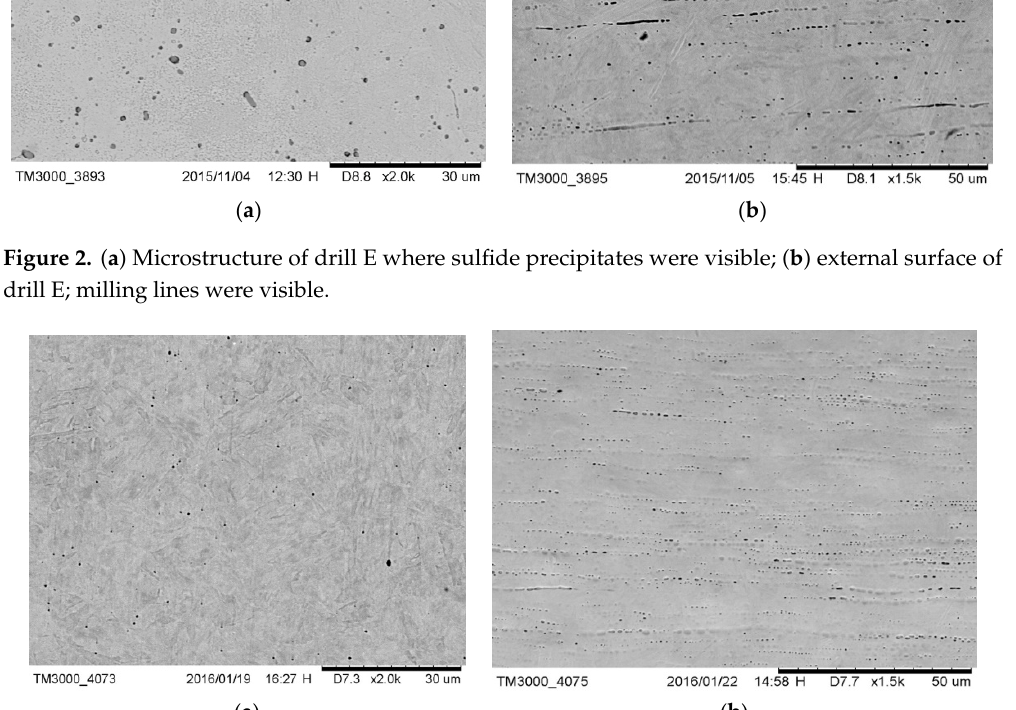
Figure 3. ( a ) Microstructure of drill B; there were no precipitates and ( b ) external surface of drill B; milling lines were visible.